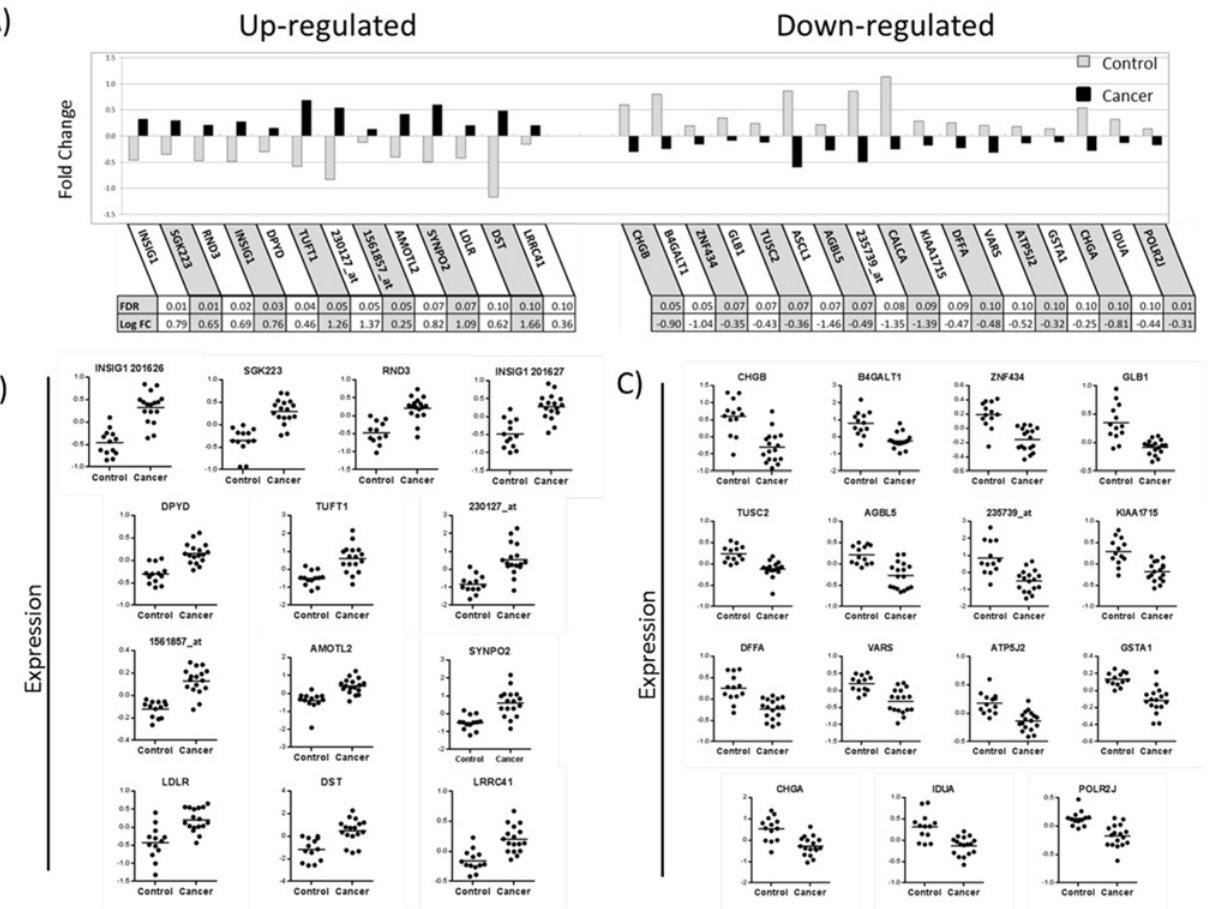
Fig 1. Top 30 Gene expressions in the peripheral airway epithelial cells. A) Using Affymetrix Gene Chip HG U133 Plus 2.0, Top 30 differentiated mRNAs in peripheral airway field of cancerization of cancer patients (black bar) vs. peripheral airways of smoker controls (gray bar) are shown. 13 mRNAs were strongly up-regulated and 17 mRNAs were strongly down-regulated in peripheral airway field of cancerization. Gene expression fold change is shown as the mean expression relative to a reference value. Table below shows FDR value base on Benjamini-Hochberg multiple testing and log2 fold change value of cancer patient relative to smoker control. B) Individual dot plot of cancer patients (n = 17) compared to smoker controls (n = 13) with up-regulated mRNAs. C) Individual dot plot with down-regulated